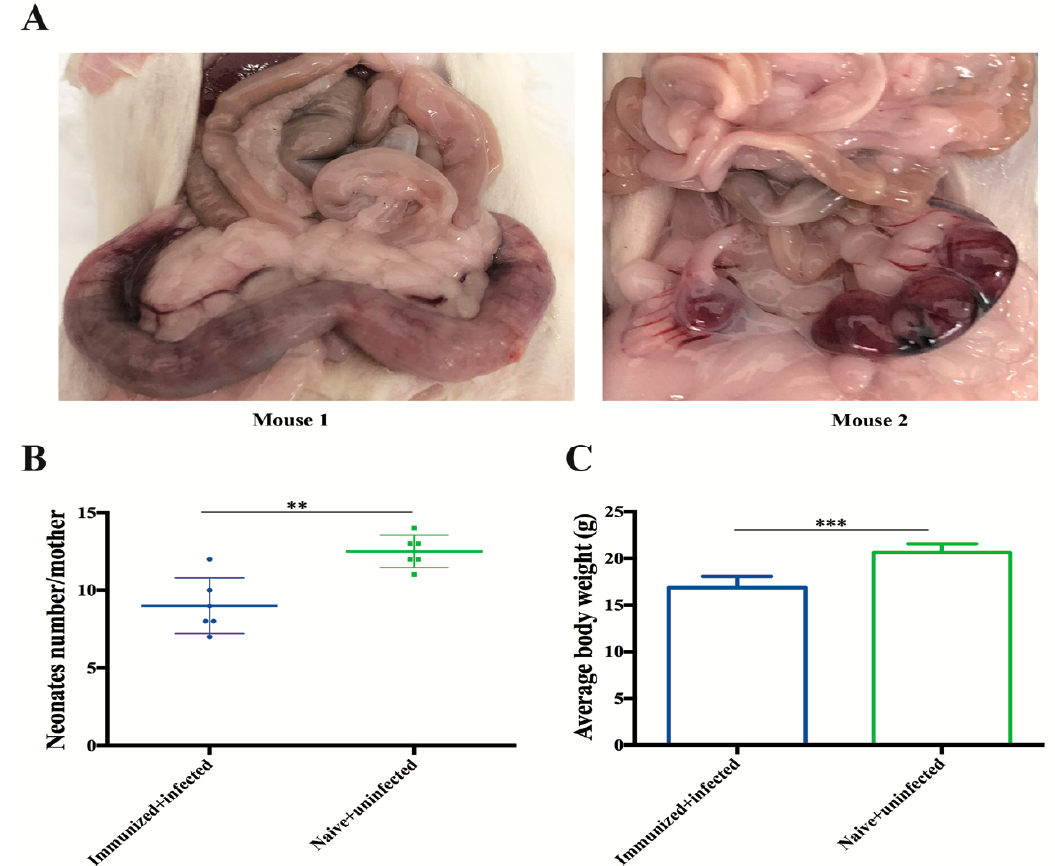
Figure 8. Protection of RH ∆ gra17 ∆ npt1 -vaccinated mice against type II Pru oocyst infection on day 5 of gestation. Two mice from the unvaccinated + oocyst-infected group were unable to eat or drink and were euthanized on days 14 (Mouse 2) and 17 (Mouse 1) after infection. Significant pathologic lesions were observed in their uterus ( A ). The litter size ( B ) and average body weight ( C ) of pups born to unvaccinated + uninfected mice versus RH ∆ gra17 ∆ npt1 -vaccinated mice + infected mice were assessed at 30 days after birth. Data points are represented as means ± SD. Statistically significant difference compared with unvaccinated + uninfected (naïve) mice: **, p < 0.01, ***, p < 0.001. One month after birth, pups and dams from RH ∆ gra17 ∆ npt1 -vaccinated + oocyst-infected mice